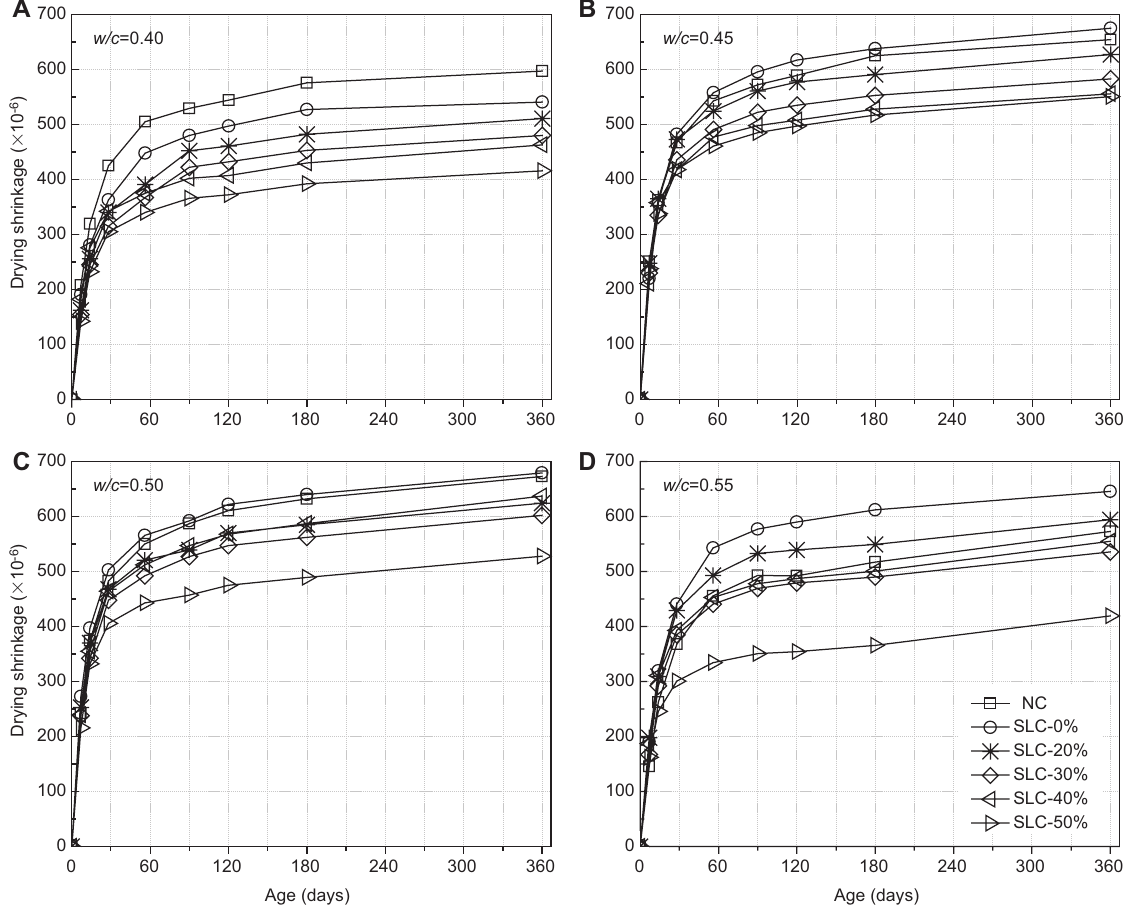
Figure 7 Drying shrinkage of “ sandless ” concrete of different w/c